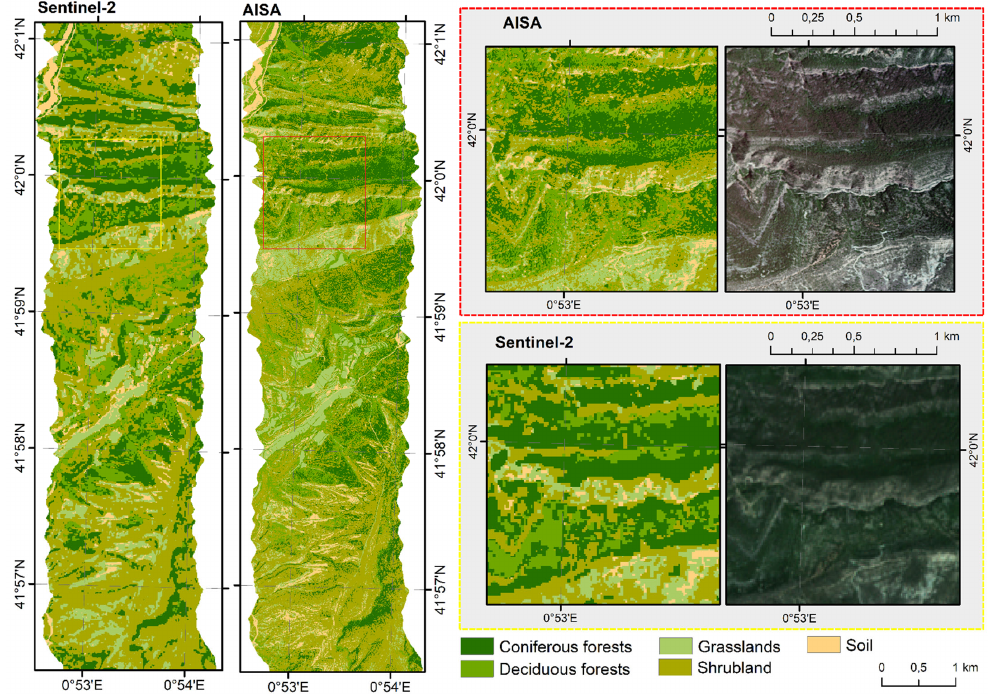
Figure 8. Classification RF results for the Sentinel-2 (Image + CHM data set) and AISA data (MNF+CHM+INDICES data set) for the B area.